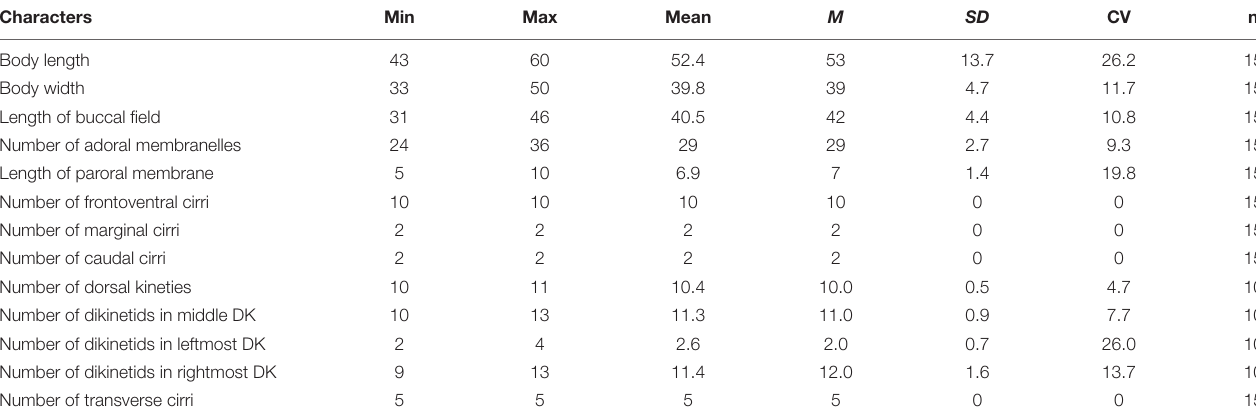
Number of dorsal kineties Number of dikinetids in middle DK Number of dikinetids in leftmost DK Number of dikinetids in rightmost DK Number of transverse